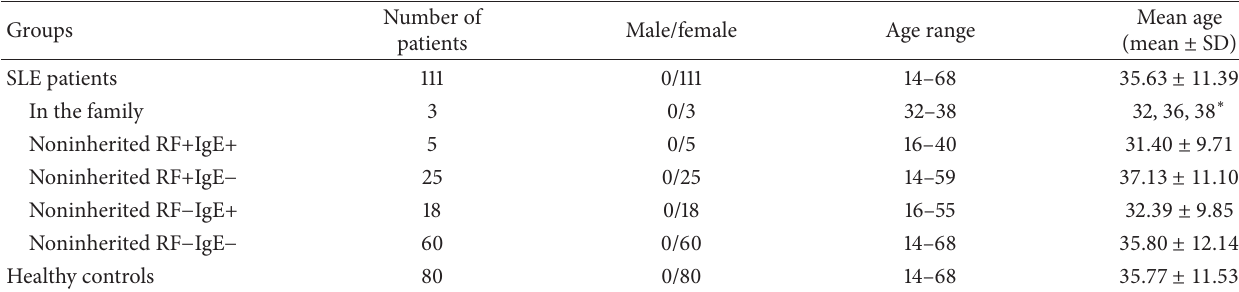
Table 1: Demographics of the